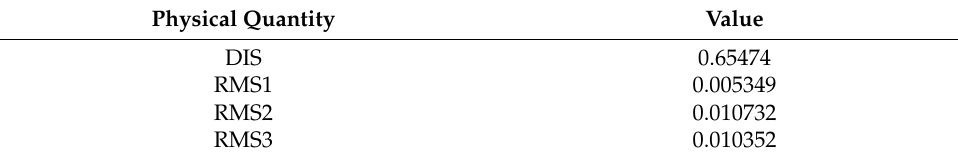
Table 8. DIS and RMS values of optimized objects.